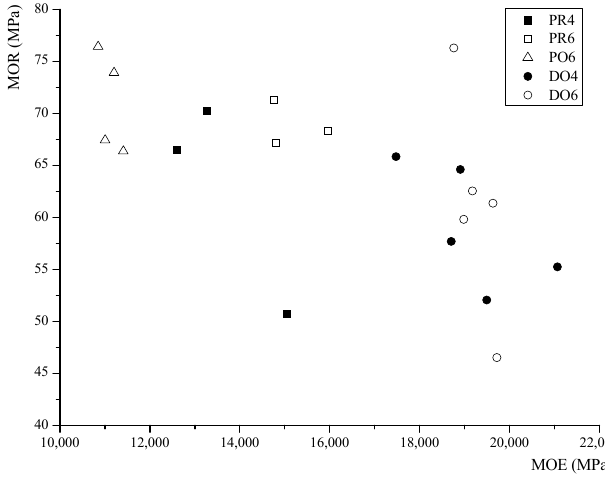
Figure 6. Scatter plot of MOR versus MOE for each series.